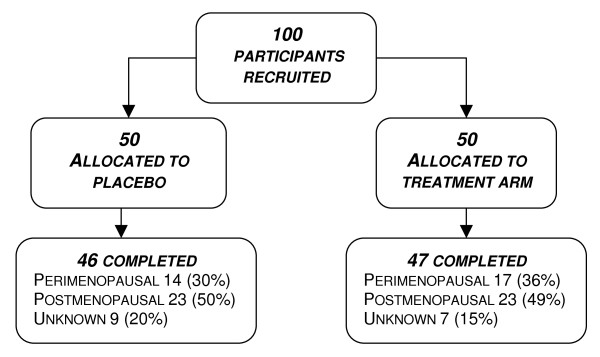
Participant flow.